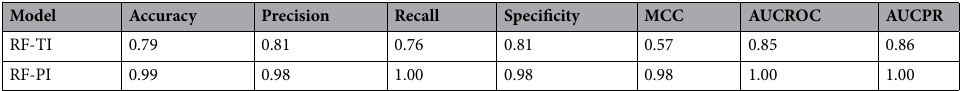
Table 1. The average performance scores of the RF models in fivefold cross-validation, where the original training set of each RF model was split into five pairs of training and test sets (please refer to the Materials and Methods Section for the details). MCC Matthews correlation coefficient, AUCROC the area under the receiver operating characteristic curve, AUCPR the area under the precision-recall